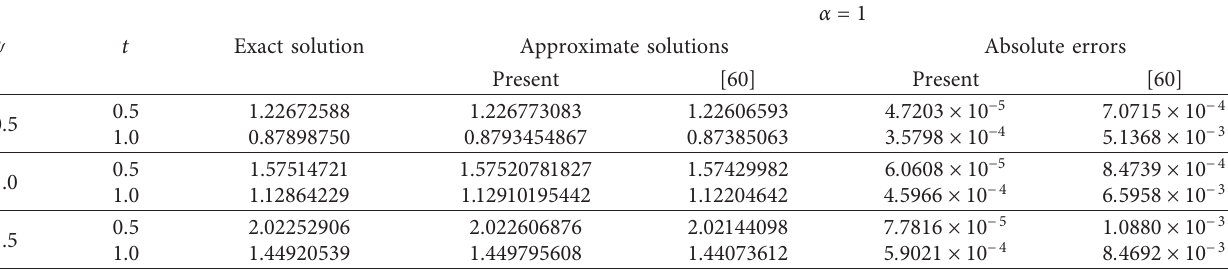
Table 1: Comparison of exact and approximate solutions and absolute errors for equation (1).